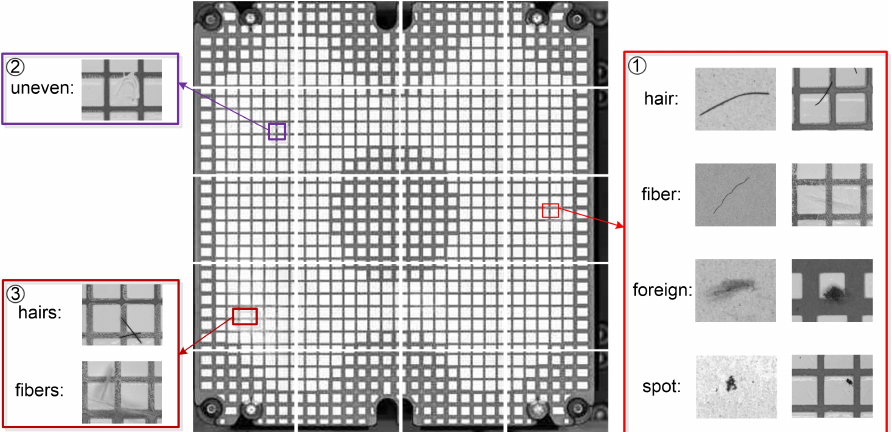
Figure 8. Seven classes of fractal objects in the IGBT